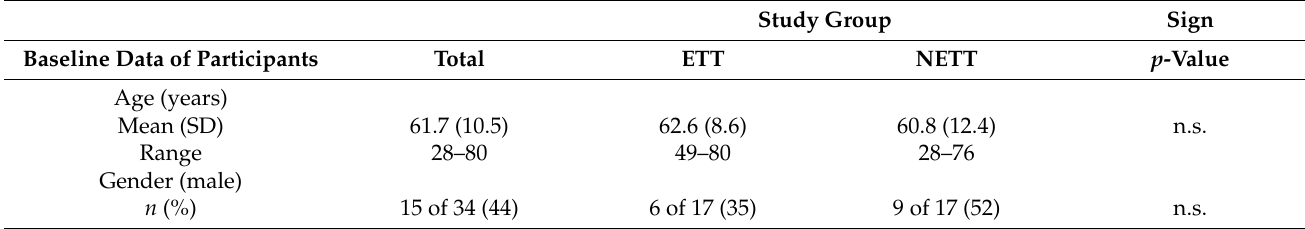
Table 1. Baseline characteristics of the participating patients at the time of augmentation procedure with autogenous dentin.